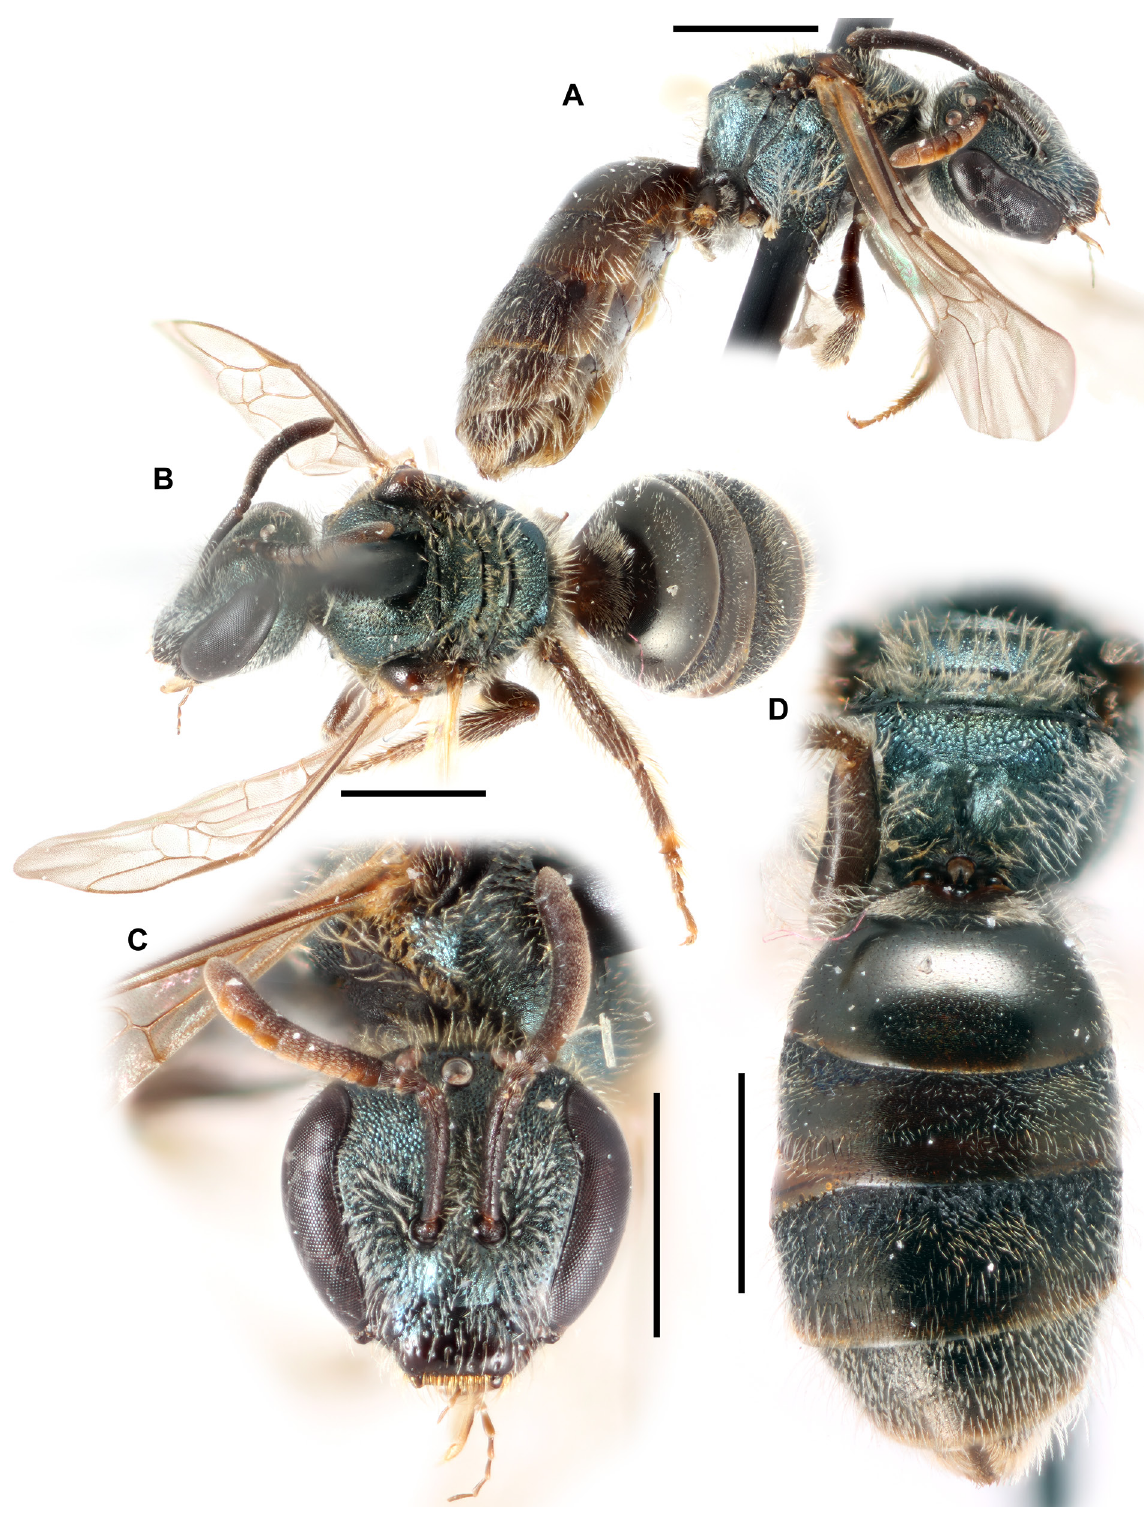
Fig. 54. Lasioglossum ( D .) puteulanum Gibbs, 2009, ♀, holotype (PCYU). A . Lateral habitus. B . Dorsal habitus. C . Face. D . Metasoma and propodeum. Scale bars = 1